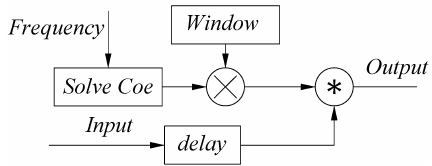
Figure 9. Diagram of a variable coefficient filter